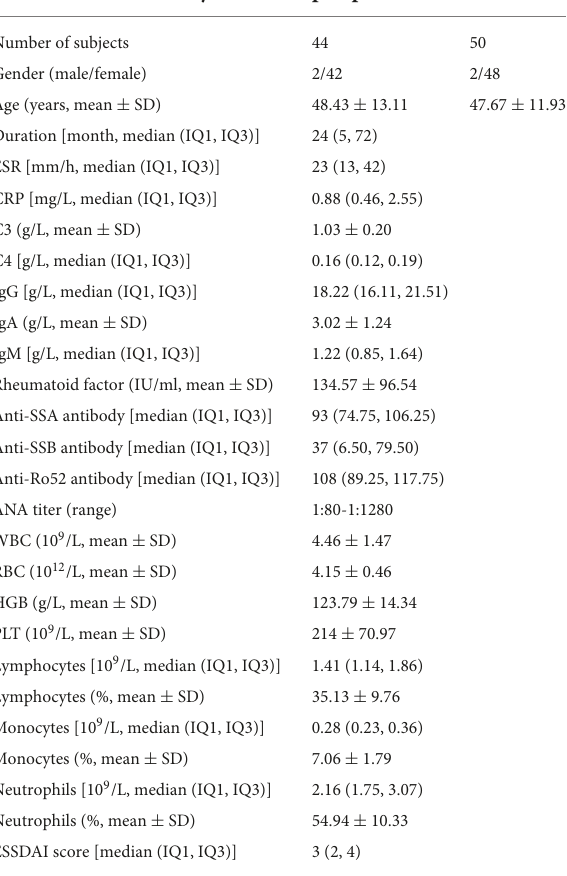
TABLE 1 Clinical details of patients with primary Sjögren’s syndrome (pSS) and healthy controls (HCs). Clinical and laboratory features pSS patients